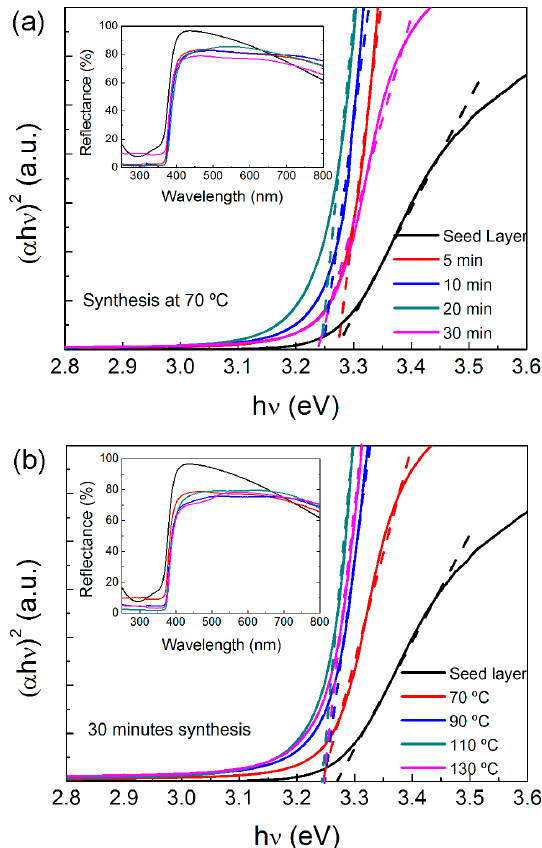
Figure 4. Tauc plots used for the determination of the optical band gap of the ZnO nanorod arrays produced by the hydrothermal method assisted by microwave radiation, on cardboard substrate: ( a ) with a temperature of 70 °C for 5, 10, 20 and 30 min; ( b ) for 30 min with a temperature variation between 70 and 130 °C.